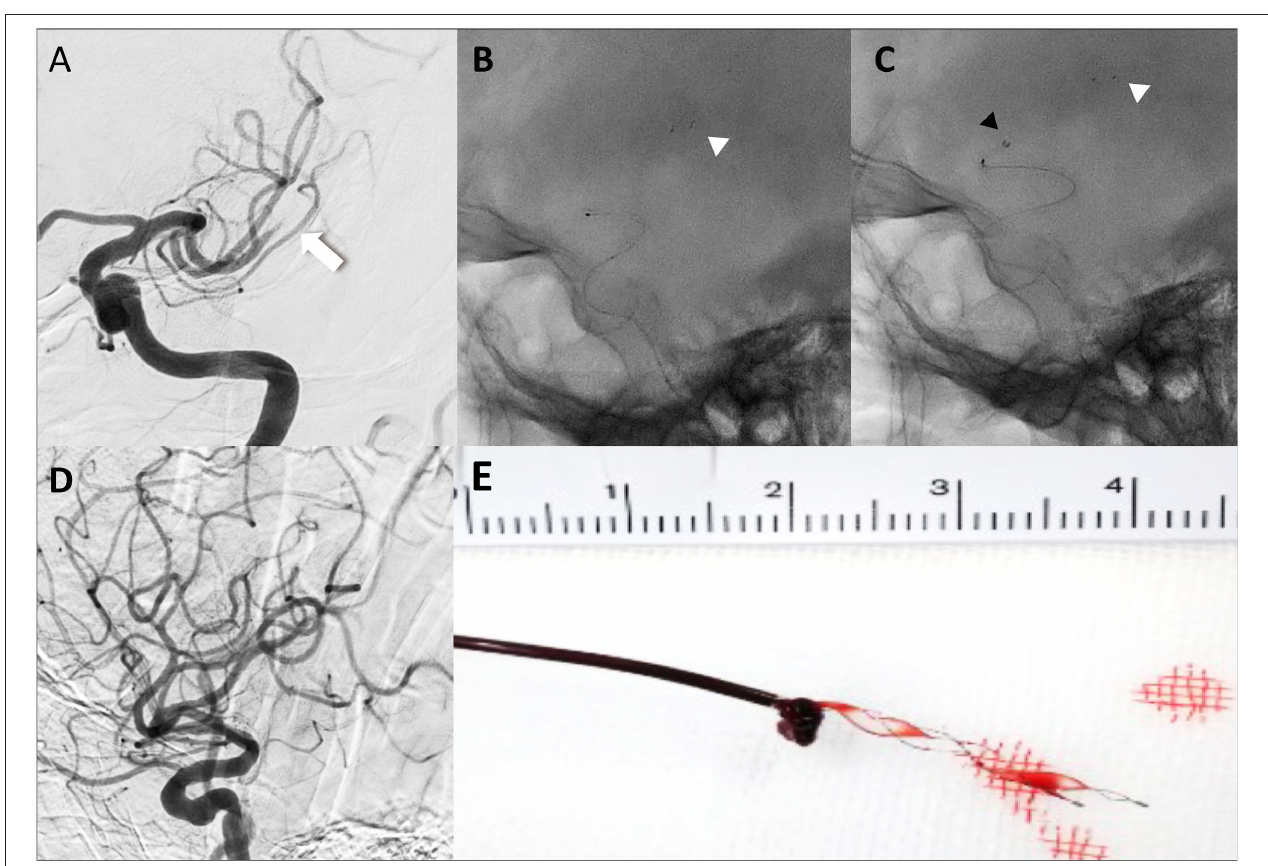
FIGURE 2 | Illustrative cases of the blind exchange and mini-pinning technique using a Tron stent retriever to remove a clot. Illustration of blind exchange and mini-pinning using the Tron stent retriever in a dominant and proximal middle cerebral artery M2 occlusion. (white arrow: proximal end of the clot) (A) Lateral angiogram showing an M2 occlusion. (B) A 0.0165-inch microcatheter in place after deployment (white arrowhead: distal end of the retriever). (C) The 3MAX aspiration catheter is advanced into the face of the clot (black arrowhead) over the bare retriever delivery wire. (D) Final angiogram showing successful reperfusion. (E) Mini-pinning (2-mm Tron stent retriever and 3MAX aspiration catheter) with “corking” of the